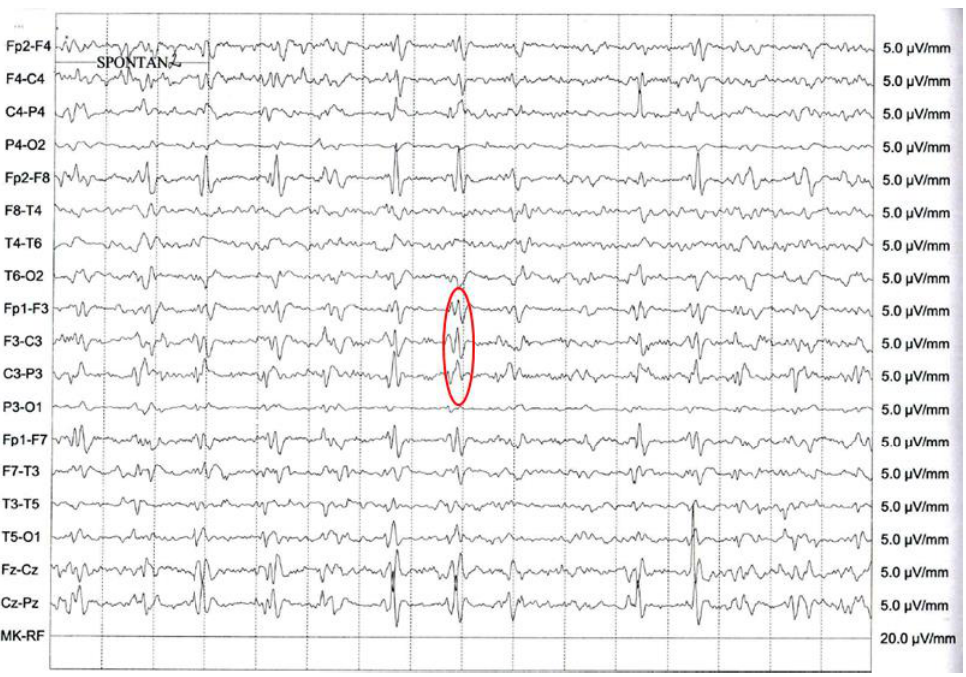
Figure 2. Periodic sharp wave complexes (PSWC) on the electroencephalography (EEG) recording of the patient. The red circle highlights the PSWC.